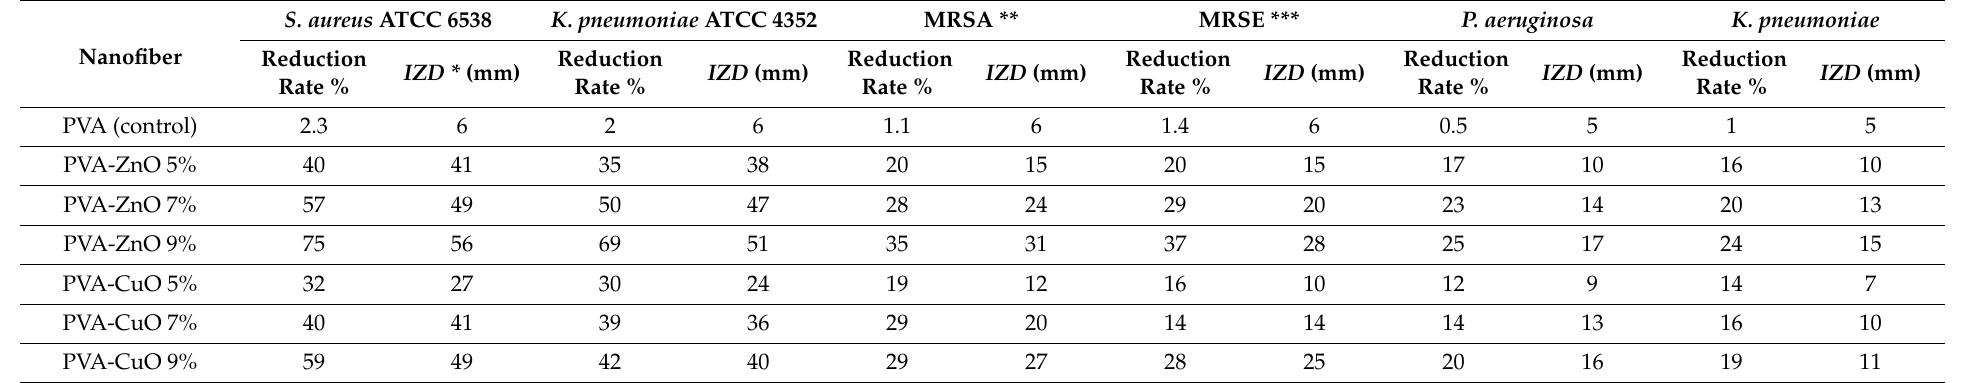
Table 2. Multi-drug resistant antibacterial activity of the prepared nanofibers of PVA, PVA-ZnO, and PVA-CuO nanofibers with different concentrations.